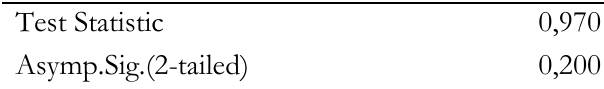
Table 3. Kolmogorov-Smirnov Result Test Statistic Asymp.Sig.(2-tailed)